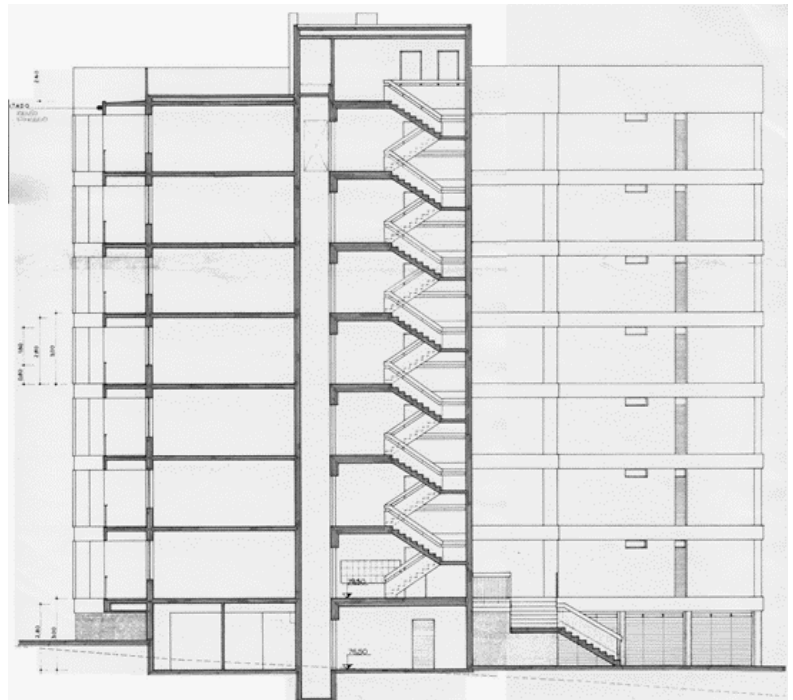
Figure 18. Section. Figure 18.